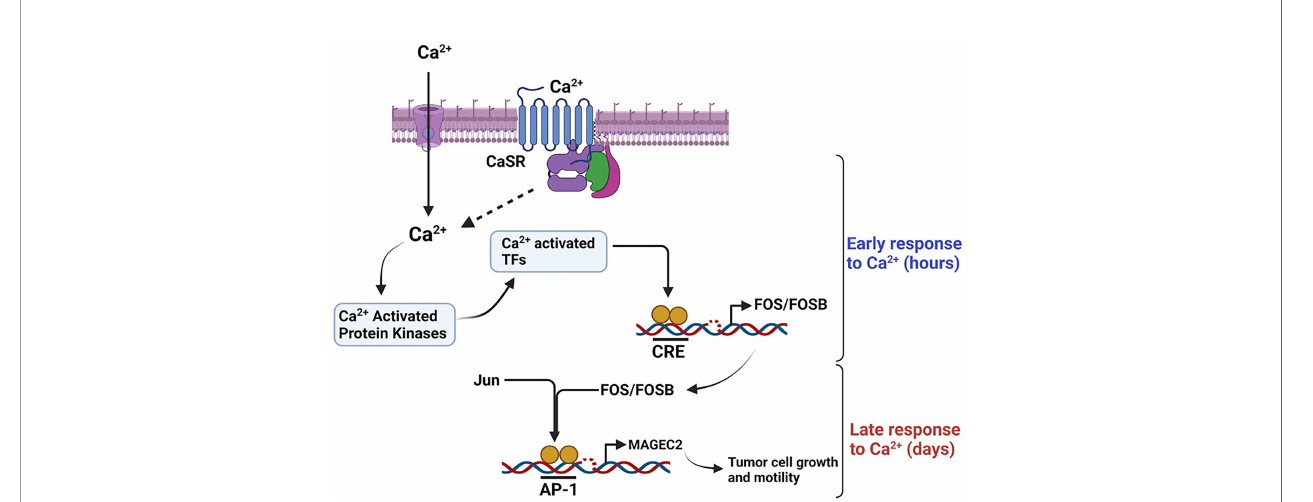
FIGURE 8 | Schematic diagram depicting the effect of high Ca 2+ on the expression of MAGEC2 in TNBC cells. High extracellular Ca 2+ acting via the CaSR provokes store operated Ca 2+ entry, the subsequent surge in intracellular Ca 2+ activates Ca 2+ activated kinase such as conventional PKC isoforms which in turn activate immediate early Ca 2+ activated transcription factors such as CREB/ATF4. These transcription factors lead to the expression of early response genes such as c-FOS which upon dimerization with Jun proteins bind to the AP-1 site on target genes such as MAGEC2 and provoke their transcription. Up regulation of MAGEC2 may then facilitate the adaptation of the cells to high Ca 2+ and enhance their growth and metastatic